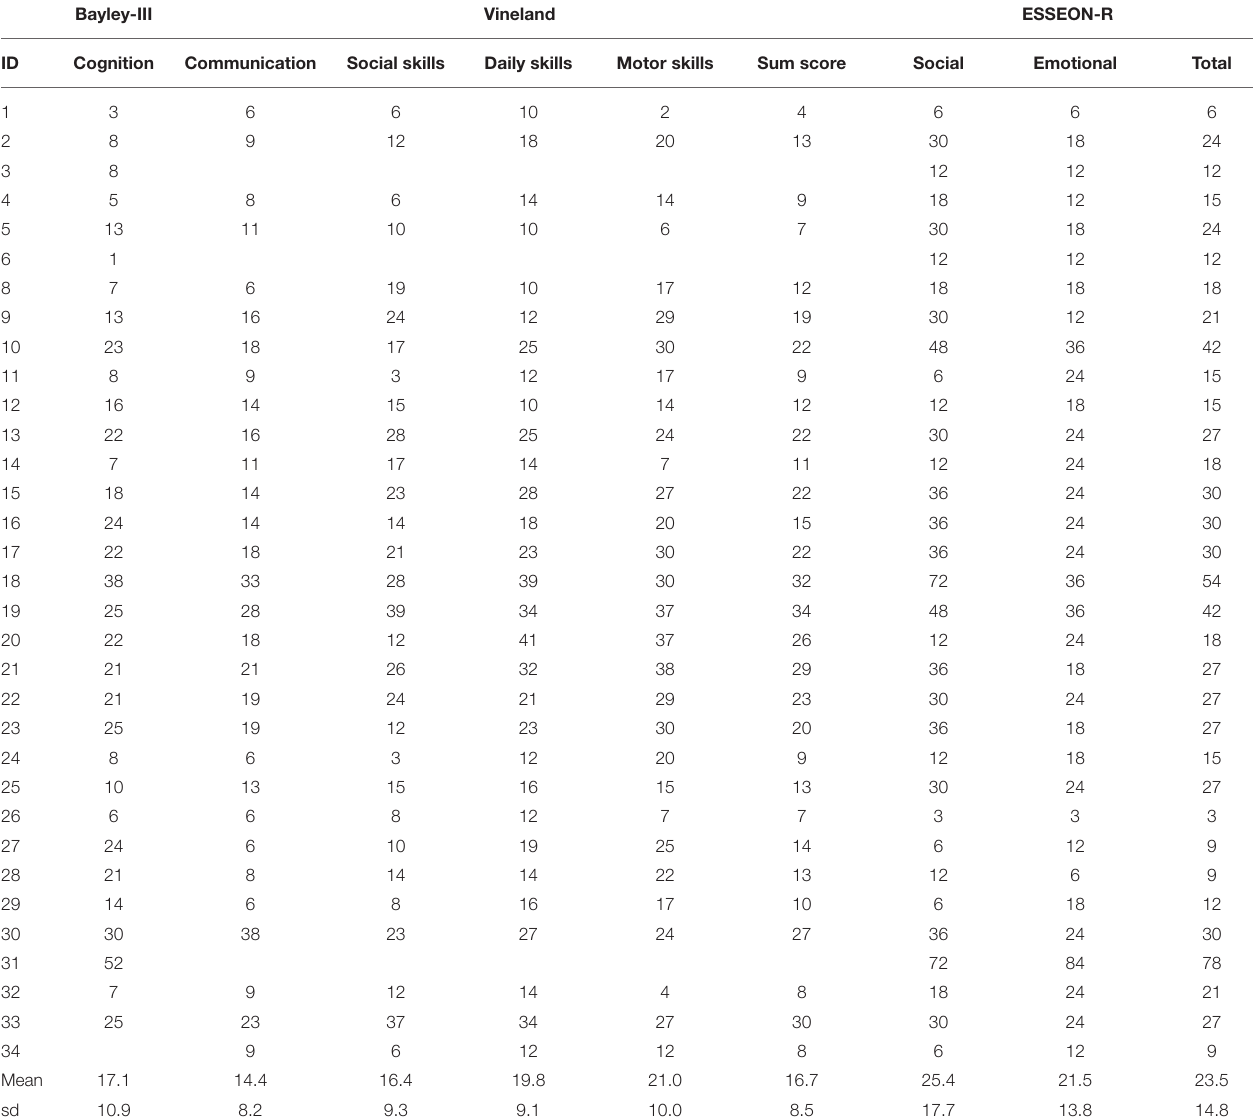
TABLE 2 | Developmental Age Equivalents (DAE) in months of cognition (Bayley-III), adaptive behavior (Vineland), and social-emotional development (ESSEON-R). Bayley-III Vineland